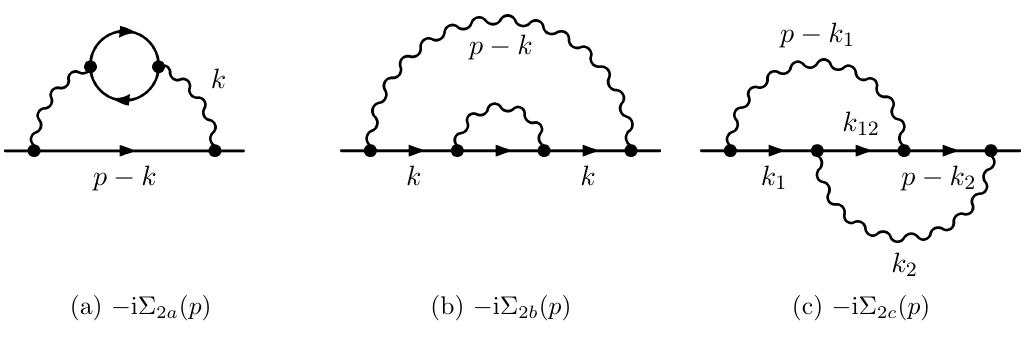
Figure 2 : 2 loop contributions to the fermion self energy ( k